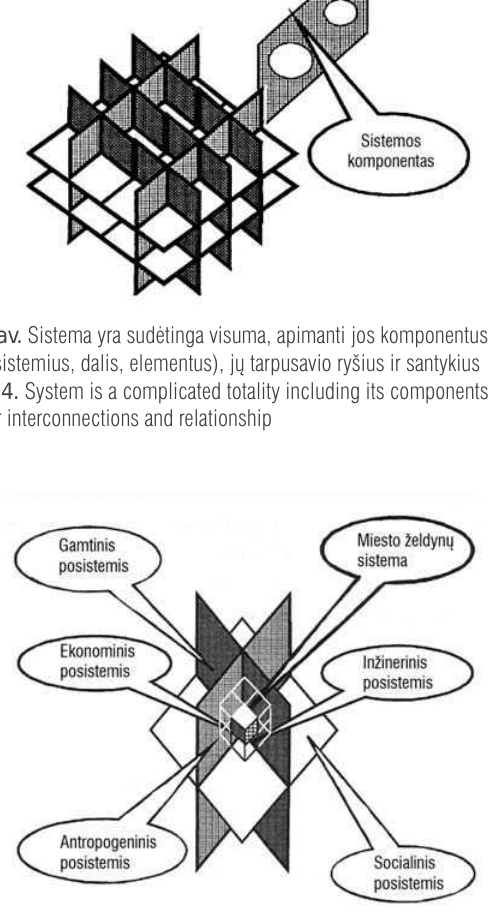
Fig 5. Model of urban green area system distribution into subsystems